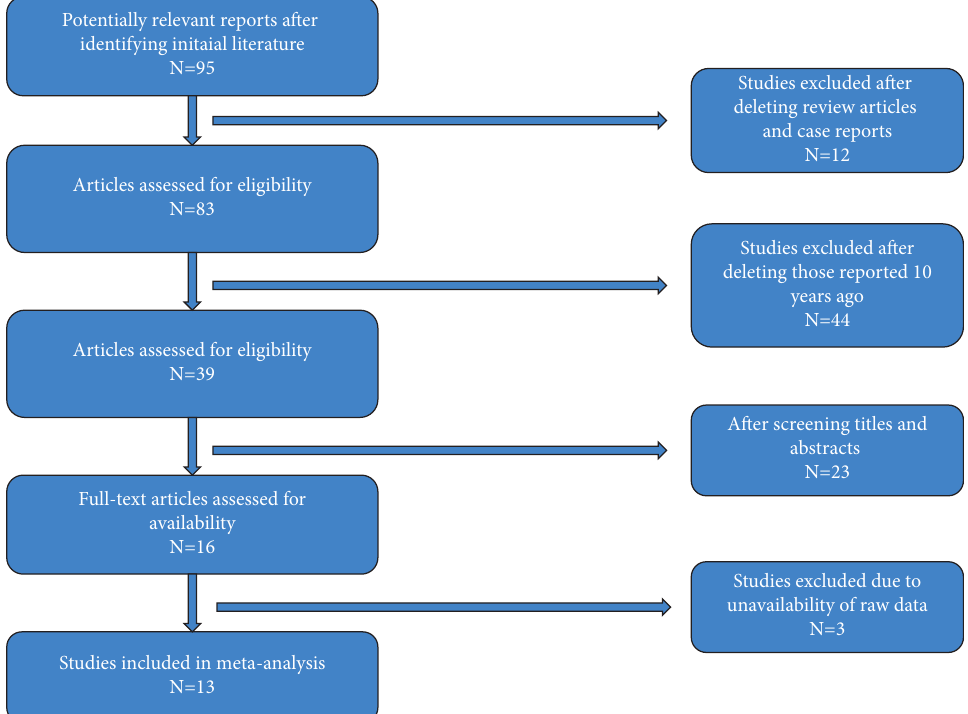
Figure 1: Flow diagram for study